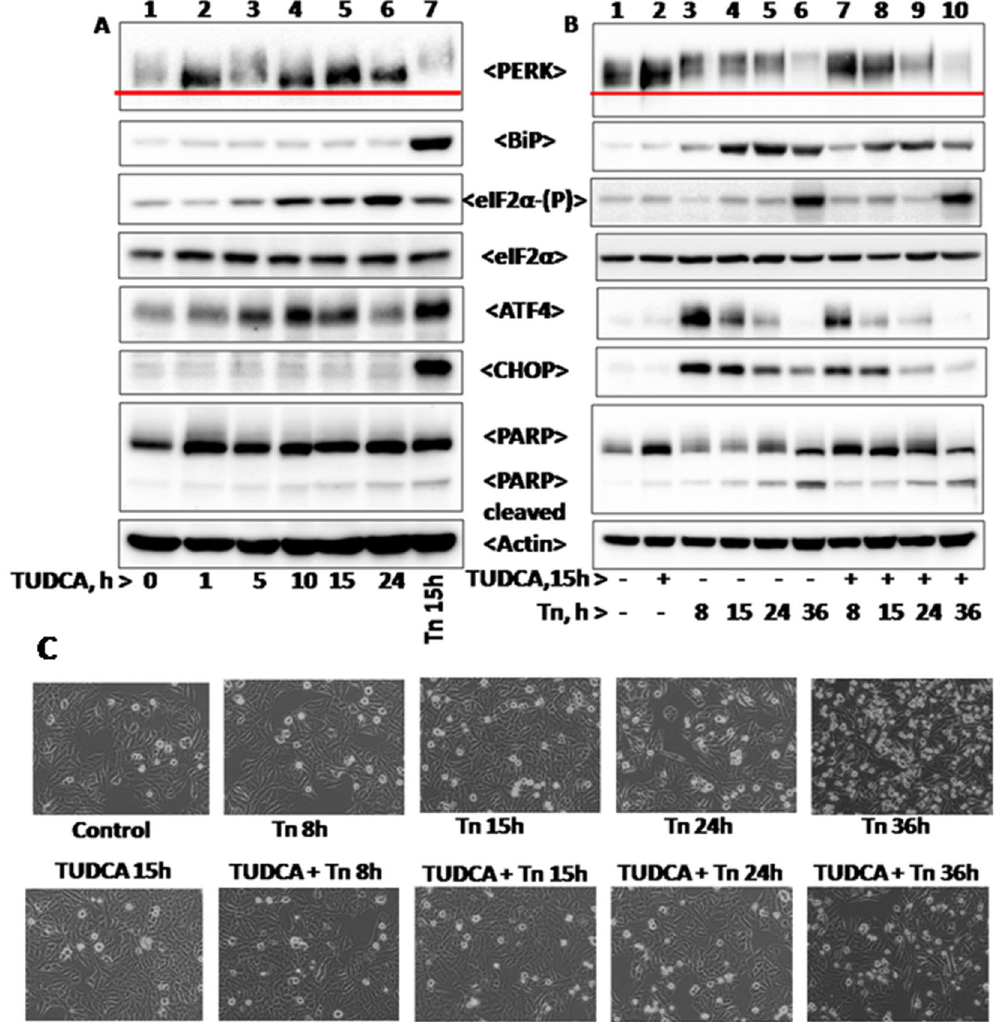
Figure 6. Tunicamycin induced UPR and PARP cleavage in the presence of TUDCA: HepG2 cells were treated with12 µ M tunicamycin, 2 mM TUDCA or with TUDCA and tunicamycin for different time periods as shown in the figure and were processed as described in Materials and Methods. Panel A represents time course analysis of different UPR marker proteins in cells treated with 2 mM TUDCA for indicated time periods. Panel B represents UPR status in cells pretreated with 2 mM TUDCA for 15 h and then incubated with 12 µ M tunicamycin for different time periods (8, 15, 24, and 36 h) as indicated in the figure. Panel C represents morphology of HepG2 cells in response to corresponding treatments as mentioned in panel